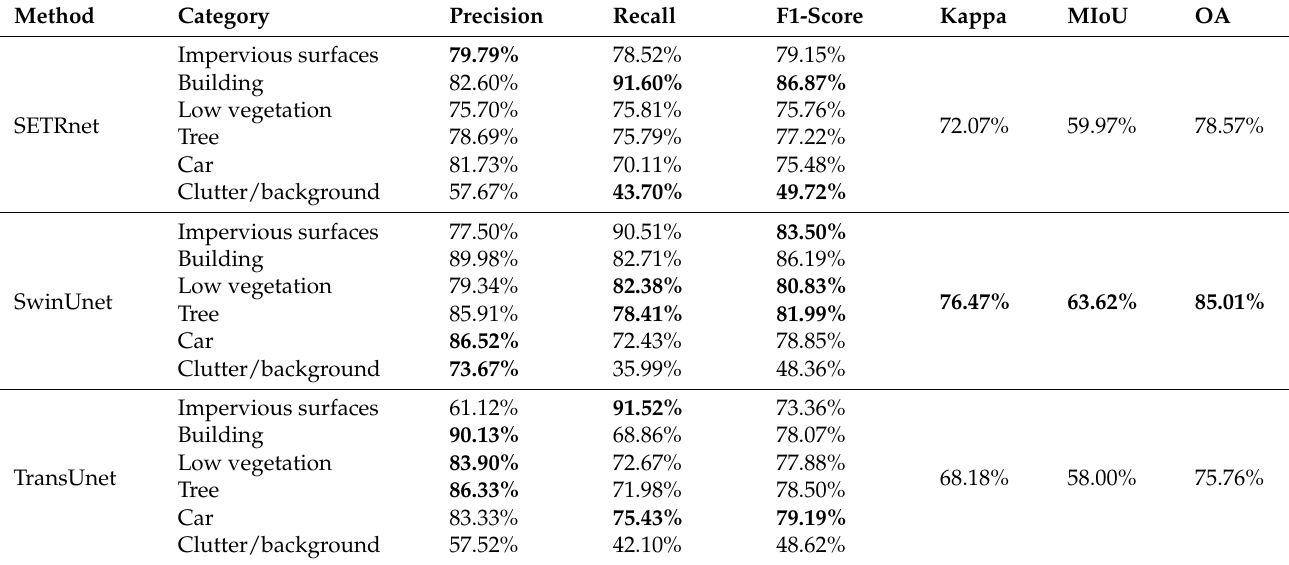
Table 4. Evaluation table of classification results in the Potsdam data set. The bolded numbers are the models with the best performance in terms of